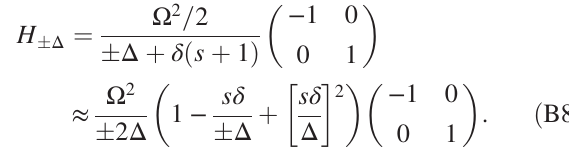
FIG. 7. Dressed-state spectrum for a single-dressing protection. Transition frequency shift as a function of the inhomogeneous shift δ , after introducing a dressing field with Rabi frequency Ω ¼ 37 MHz and detuning Δ . Left panel: For high sensor sensitivity ( s ¼ 110 ≫ 1 ), there exists one protected state (in- sensitive to δ to first order). The energy gap is dominated by the detuning Δ ¼ 400 MHz, which is much larger than Ω . Right panel: For s ¼ 1 , there exist two protected states. Optimal protection is achieved with a resonant dressing field ( Δ ¼ 0 ), and thus, the energy gap is dominated by Ω . Insets magnify the spectrum near δ ¼ 0 , revealing the magnitude of the second- order